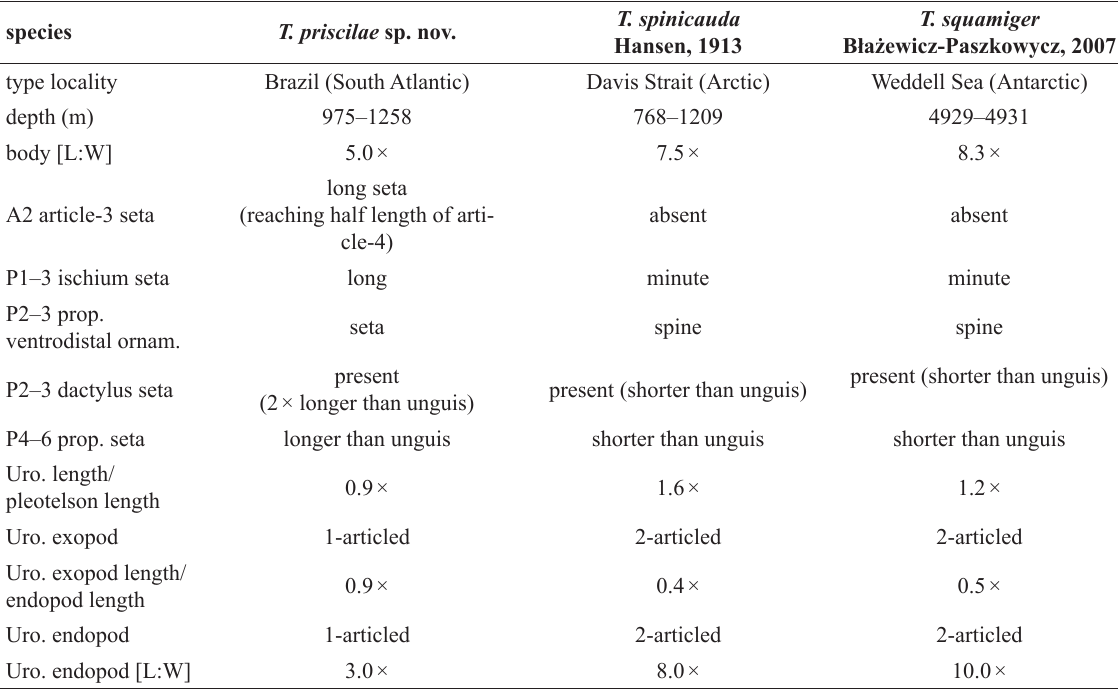
Table 4. Diagnostic characters of species of Typhlotanais ‘ spinicauda ’ group (based on females). Abbreviations: A2 = antenna; P = pereopod; Prop. = propodus; Uro. =